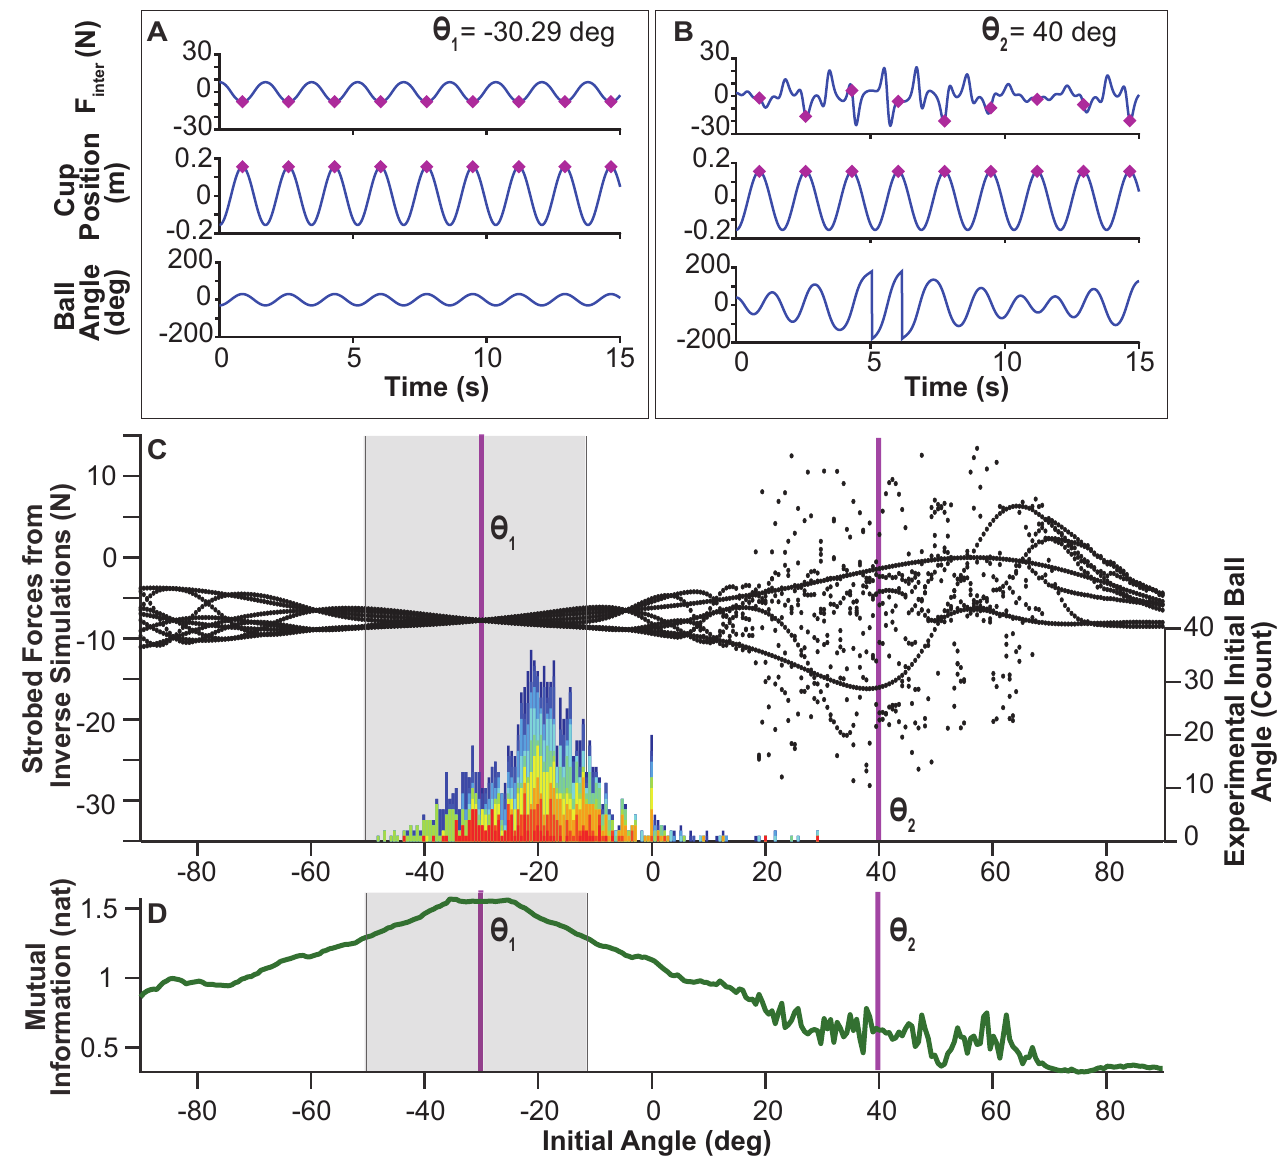
Fig 8. Effect of initial ball angle on interaction forces: A. Simulated interaction force F , cup position x(t) , and ball angle θ (t), for rhythmic cup inter (t) displacement starting with θ 1 = − 30.29 deg and _ y _ = − 15.81 deg/s, the average initial ball velocity at the end of the experiment across all subjects. The cup 0 frequency and amplitude were set to experimental averages 0.58 Hz and 0.308 m (peak-to-peak). B. Simulated interaction force F , cup position x(t) , and inter (t) ball angle θ (t), for a trial initiated with θ 2 = 40 deg. The initial values for _ y _ , cup frequency and amplitude were the same as in panel A. C. Distribution of 0 strobed force F inter (t) for all initial ball angles: At every maximum of x(t) , the value of F inter (t) was determined, as displayed by the magenta points at each peak of x(t) . The marginal distributions of the strobed force profiles are plotted against the respective initial ball angle θ 0 between -90 deg and +90 deg (the step size was 5 deg). θ 1 and θ 2 are marked with vertical lines. The gray box overlaid onto the figure denotes the range of initial ball angles for which the simulated ball position data remained below ± 50 deg, i.e. the ball did not escape. The figure also includes a histogram of experimental values of θ 0 for all trials pooled over all subjects; different subjects appear in different colors. The mode of the distribution of the experimental data was at -22.68 deg. D. Mutual information ( MI ) between the simulated F profile and the cup kinematics for each θ 0 . Higher MI values indicates higher degrees of predictability. The initial ball angles that inter (t) produce the highest MI values align with the θ 0 that produce the least complex distributions of the strobed F inter ( t